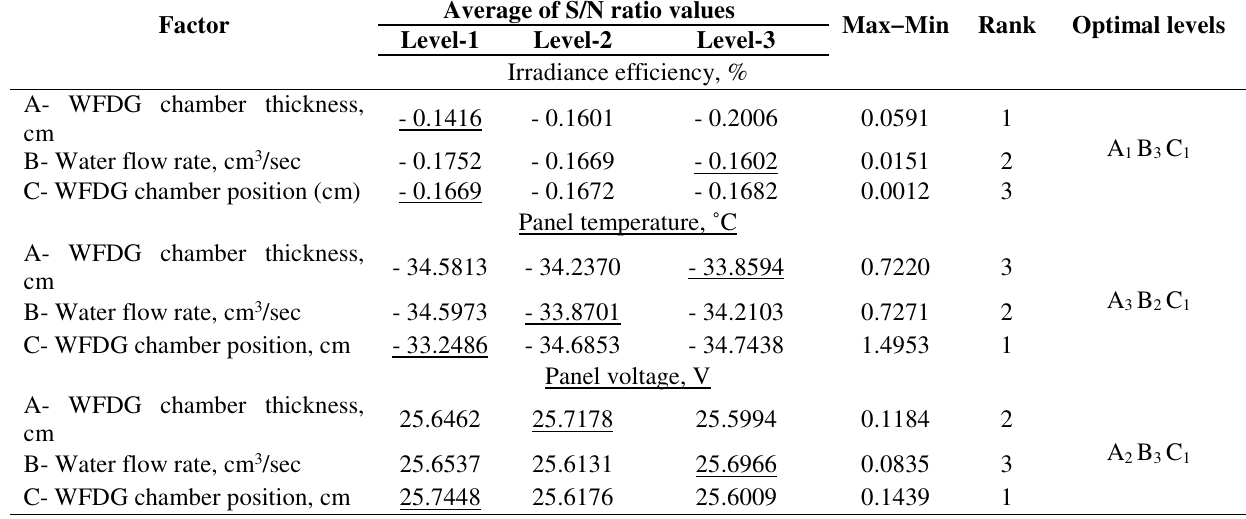
Mean S/N ratios for different factors (Underlined value represents the optimum